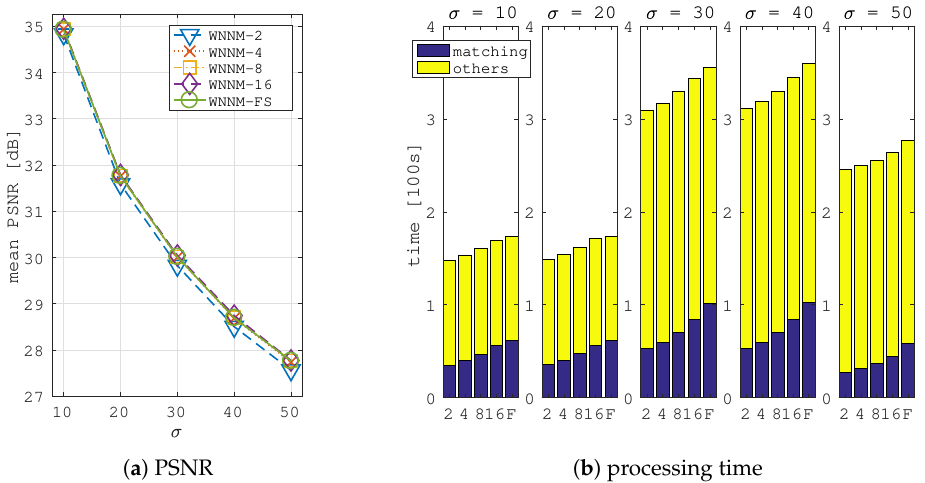
Figure 11. OTSHT vs. FS. ( a ) Mean PSNR and ( b ) mean processing time of WNNM-FS and WNNM- K in different noise levels. In the bar chart, the number and ‘F’ of y-axis are the number of limited basis images and FS, respectively. Table 4. Mean PSNR of WNNM with FS (WNNM-FS) and WNNM with OTSHT and OHT using K limited basis images (WNNM- K ) in different noise